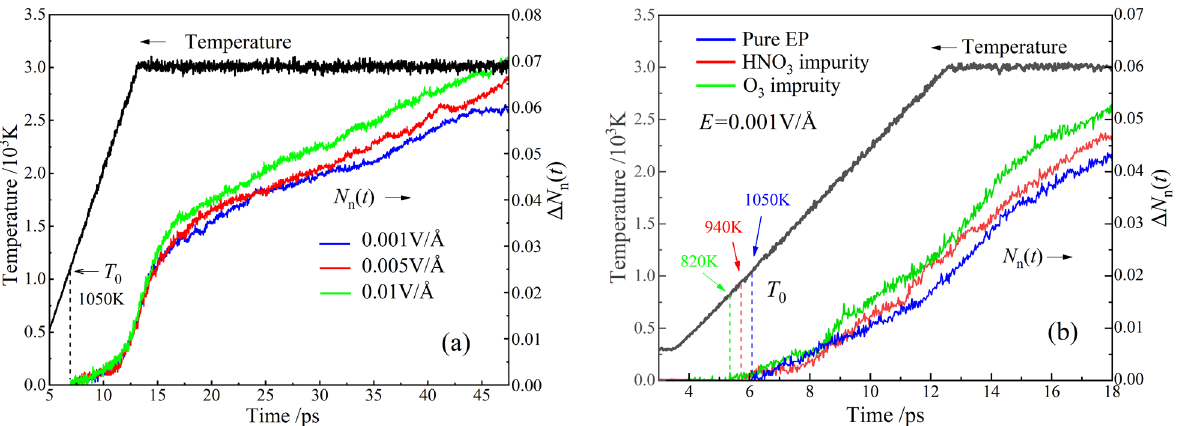
Figure 2. Normalized increment of molecule number with time in reactive MD processes of the crosslinked EP polymer models ( a ) without molecular impurity and ( b ) with active molecular impurities under thermal–electrical synergy (electric field + raised temperature).